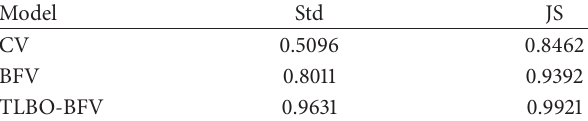
Table 3: Results of Figure